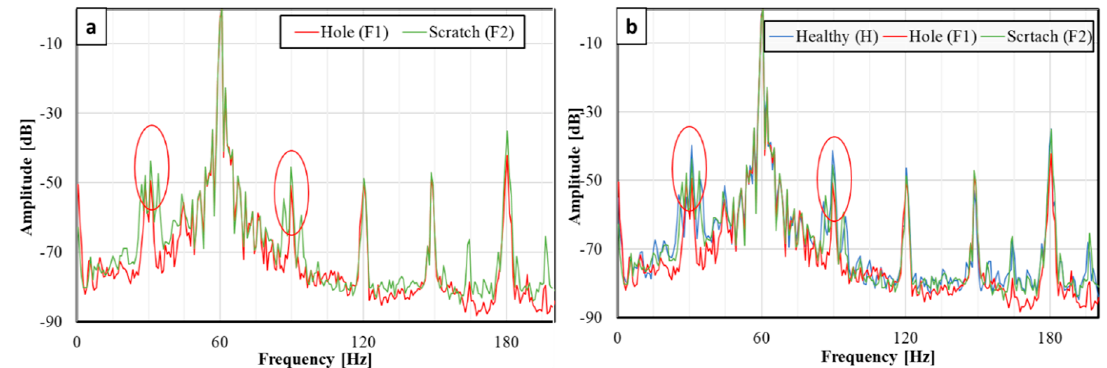
Figure 4. ( a ) Frequency spectrum of class F1F2 at a rotating speed of 1765 min − 1 ; and ( b ) frequency spectrum of class HF1F2 at a rotating speed of 1765 min –1 .